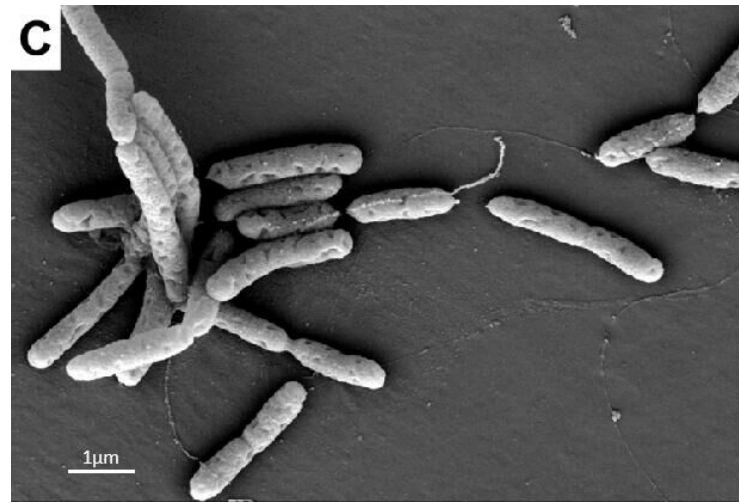
Figure 7. Scanning electron micrographs of the bacteriostatic treatment of R. solanacearum . ( A ). The strains incubated at 30 °C for 24 h were designated the blank control group at 1000 K× magnification. ( B ). The strains treated with 4 mg/mL PLGA-NPs loaded with MC and CAPE were designated the treatment group at 1000 K× magnification. ( C ). The strains treated with 4 mg/mL PLGA-TNPs loaded with MC and CAPE were designated the treatment group at 10.75 K× magnification.